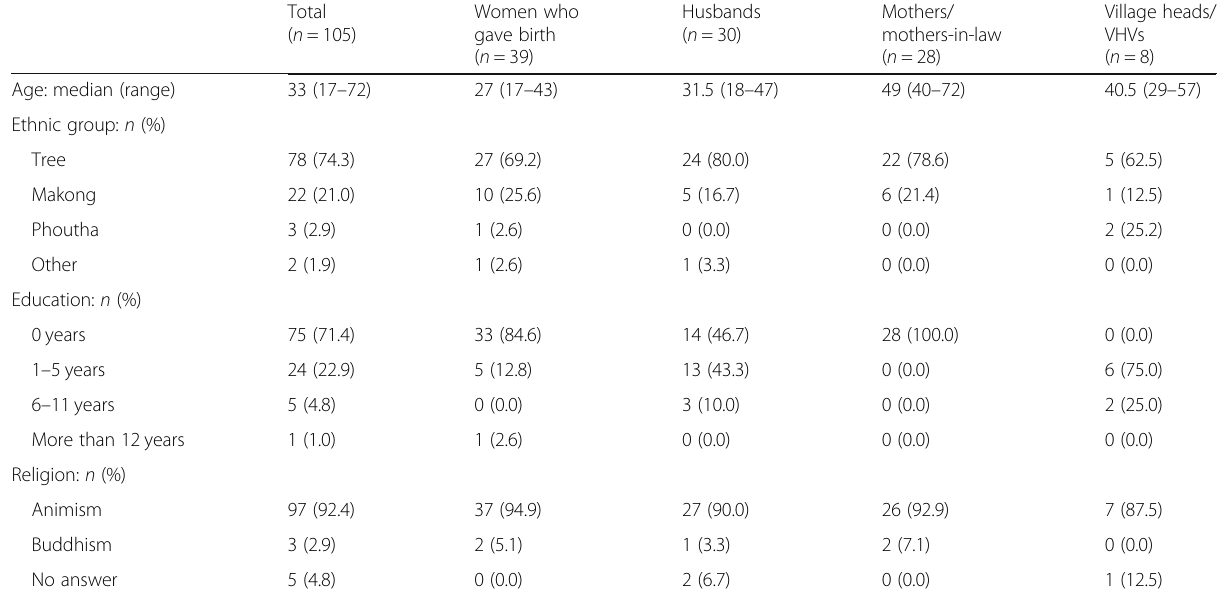
Table 1 Socio-demographic characteristics of the study participants